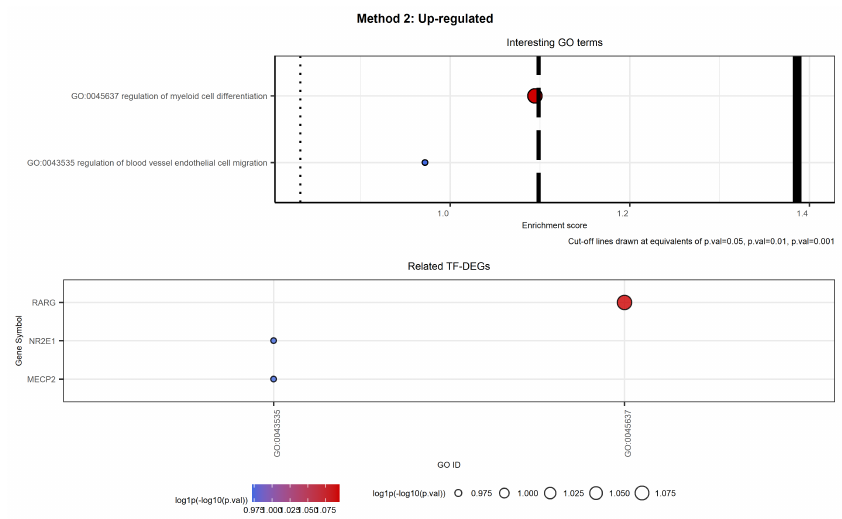
Figure 13. Interesting GO terms and related TF-DEGs. The first plot shows selected GO terms on the y -axis and the respective log1p( − log10( p -value)) as the Enrichment score on the x -axis. The second plot shows TF-DEGs on the y -axis and the related GO terms on the x -axis. In both plots, colour and size of the bubbles depend on the Enrichment score. We note that gene RARG results in being strictly CML-related, while genes MECP2 and NR2E1 are associated with a more general biological